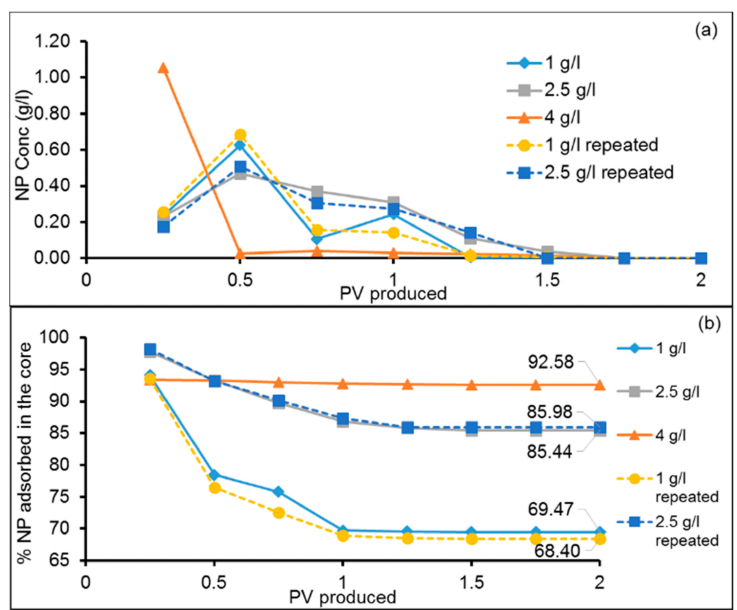
Figure 7. ( a ) Effluent NP concentration profiles and ( b ) % adsorption of NP during post flush for cores saturated with silica dispersed in DIW with MPTMS stabilizing fluid (Experiments: 4–8).